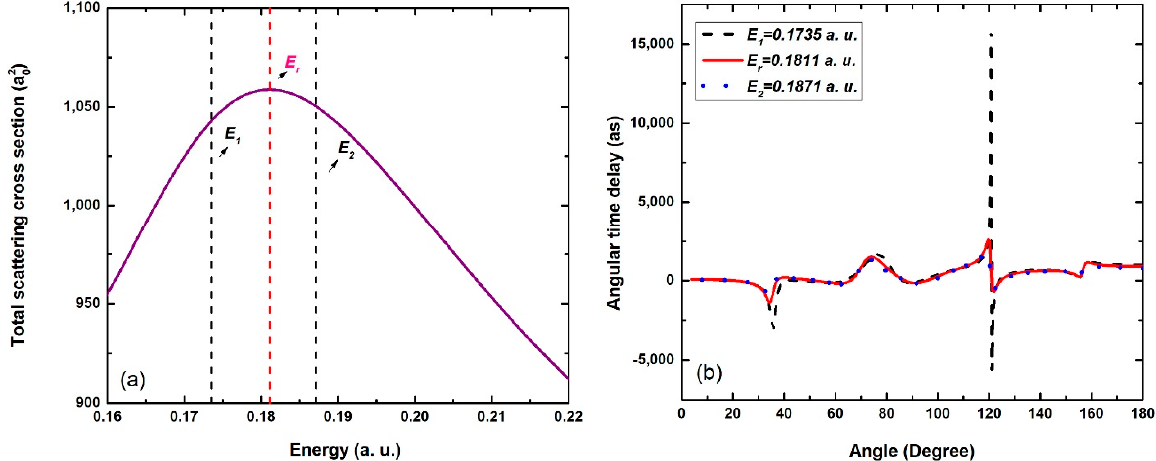
Figure 11. ( a ) Total cross-section near (cid:96) = 5 resonance and ( b ) angular time delay plotted for energies E 1 = 0.1735 a.u. (black dashed line), E r = 0.1811 a.u. (red solid line), and E 2 = 0.1871 a.u. (blue dotted line).